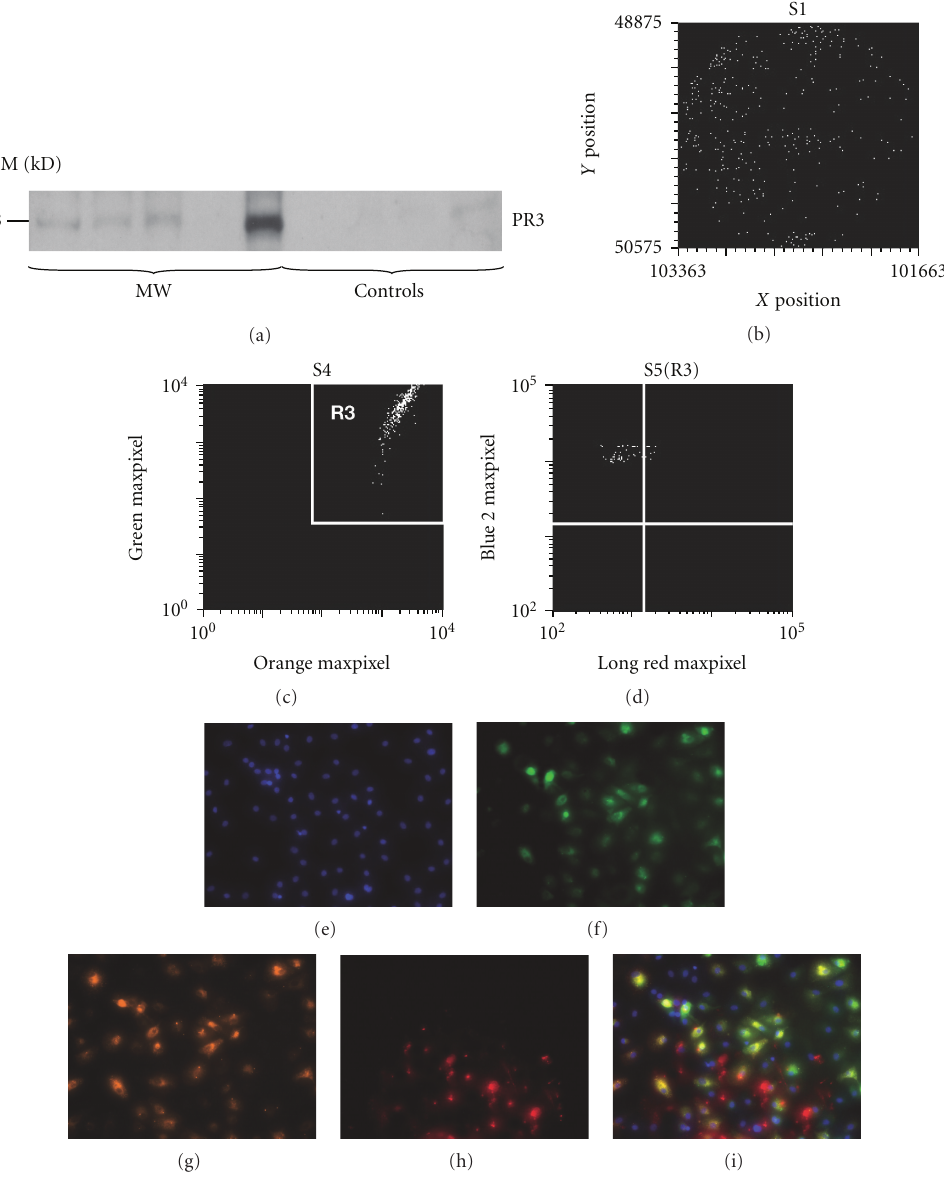
Figure 5: (a) Immunoblot analysis of eEOC plasma membrane preparations for mPR3 expression. All but one out of five GPA patients displayed significant mPR3 expression. The one individual with intense mPR3 signal was a patient that refused therapy from the beginning of the disease. (b)–(d) Laser scanning analysis of cultures eEOCs. The cells were detected by UE lectin binding (green immunofluorescence in (c)) and Dil-acLDL uptake lectin binding (red immunofluorescence in (c)). All double-positive cells were analyzed for mPR3 expression (long red in (d)). Only a minority of the cells was mPR3 positive. (e)–(i) Representative images of PR3 expression in cultured peripheral eEOCs. Cells were stained for UE lectin ((f)—green), Dil-acLDL uptake ((g)—orange), and PR3 ((h)—red). Image e merges images (e)–(h) ((e): nuclear staining with DAPI solution, magnification in (e)–(i) ×